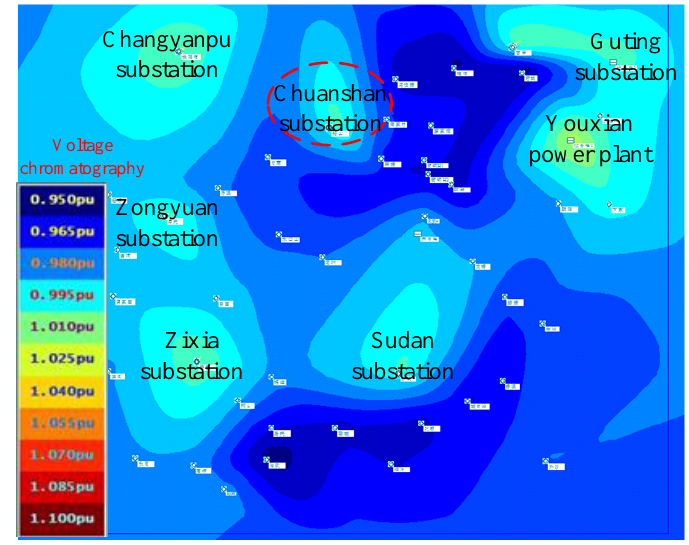
Figure 8. Local voltage distribution of 500 kV in the south of Hunan.